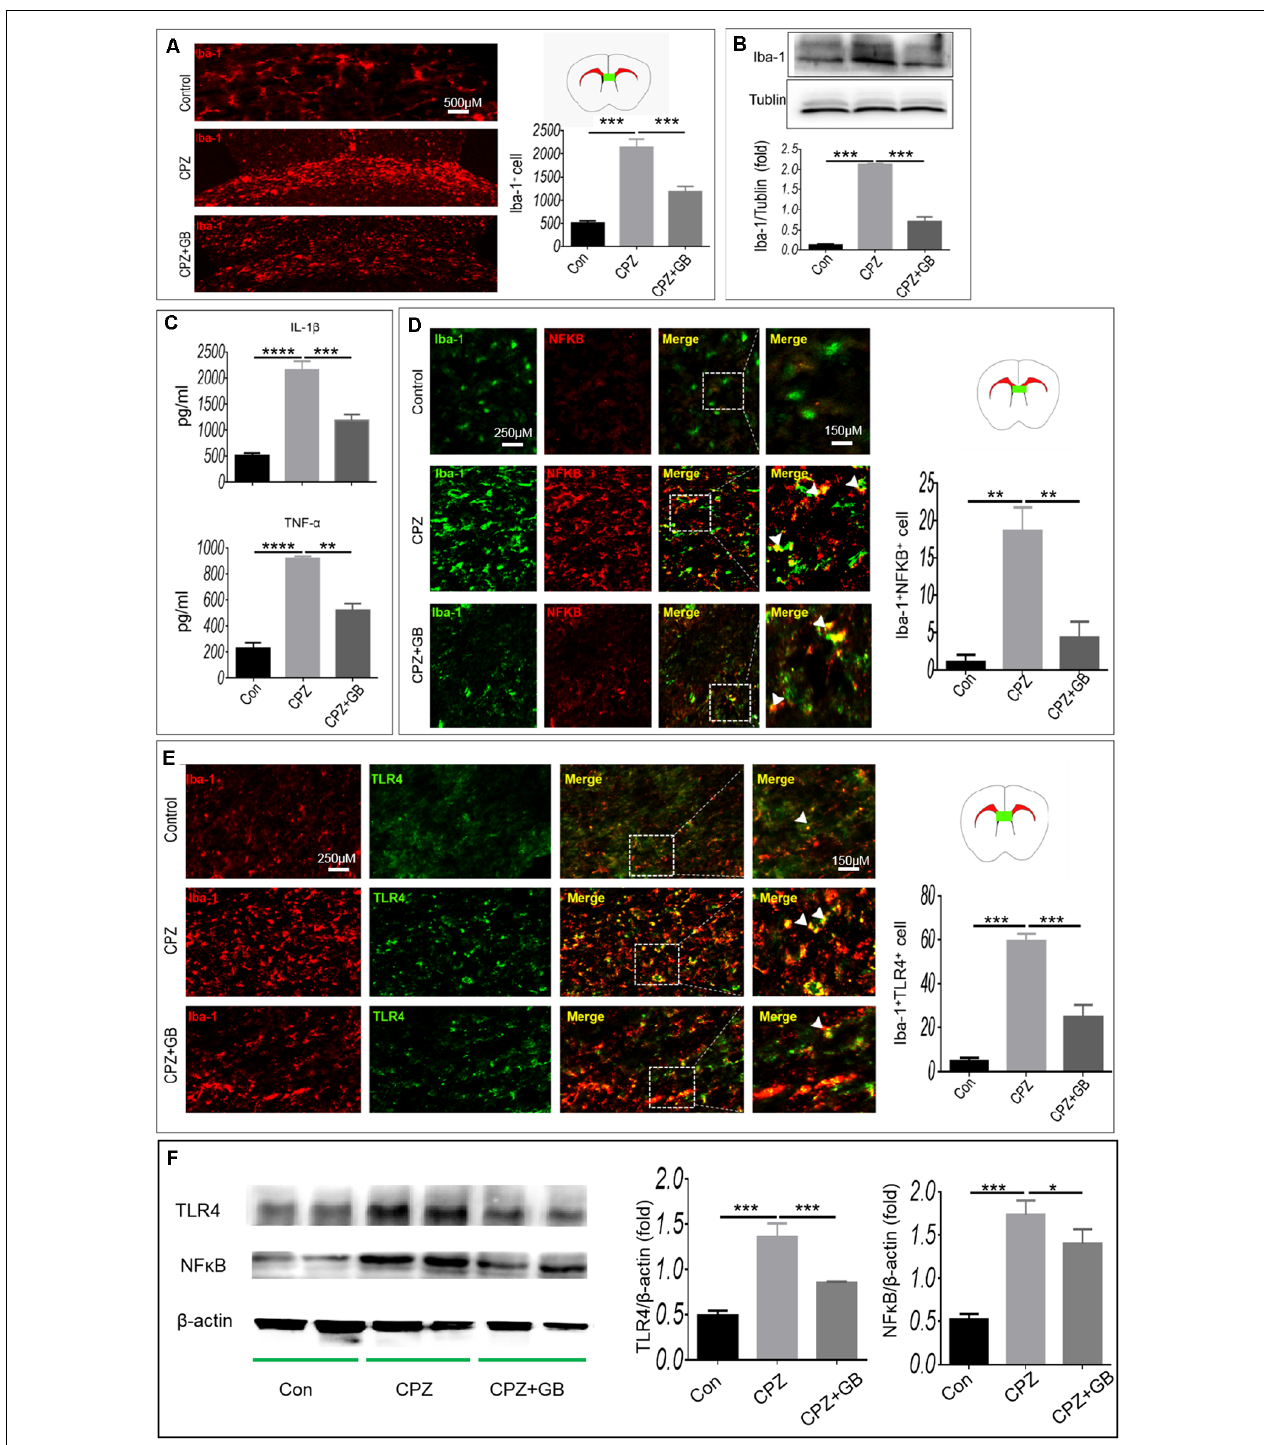
FIGURE 3 | GB inhibited the microglial inflammatory response. Mice were fed with chow containing 0.2% CPZ for 6 weeks and were intraperitoneally injected with GB for 14 consecutive days from the 4th to 6th week of CPZ feeding. (A) Iba-1 + microglia in the corpus callosum of brain by immunohistochemistry, (B) expression of Iba-1 + protein in the extract of brain by western blot, (C) levels of inflammatory cytokines IL-1 β and TNF- α in the extract of brain by enzyme-linked immunosorbent assay (ELISA), (D) double immunohistochemical staining with anti-Iba-1 and anti-p-NF- κ B/p65 in the corpus callosum, (E) double immunohistochemical staining with anti-Iba-1 and anti-TLR4 in the corpus callosum. (F) Expression of TLR4 and p-NF- κ B/p65 in the extract of the brain by western blot. Representative images are obtained from three to four mice/each group, with similar results. The results represent the mean ± SEM. ∗ p < 0.05, ∗∗ p < 0.01, ∗∗∗ p < 0.001, ∗∗∗∗ p < 0.0001.